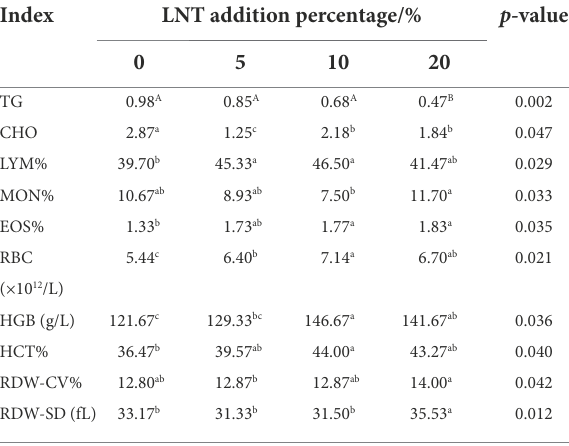
TABLE 2 Effects of LNT on blood biochemical parameters of rabbits.